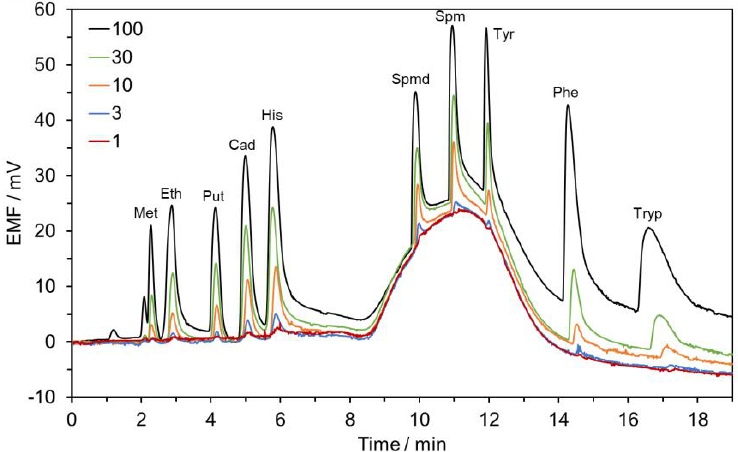
Figure 1. Chromatograms were obtained with the HPLC-POT method for the analysis of standard mixture solutions of BAs. Concentrations are given in µmol L – 1 . Chromatographic conditions: Gradient elution: A—5.0 mmol L − 1 SBS in 10.0 mmol L − 1 CH 3 COOH and B—1.0 mmol L − 1 CH 3 COOH:ACN 1.2 mL min − 1 . Injection volume: 100 µ L. Table 2. Linearity, recovery range of BAs for three concentration levels (%), relative standard devi- ation (%RSD), the limit of detection (LOD), and limit of quantification (LOQ).